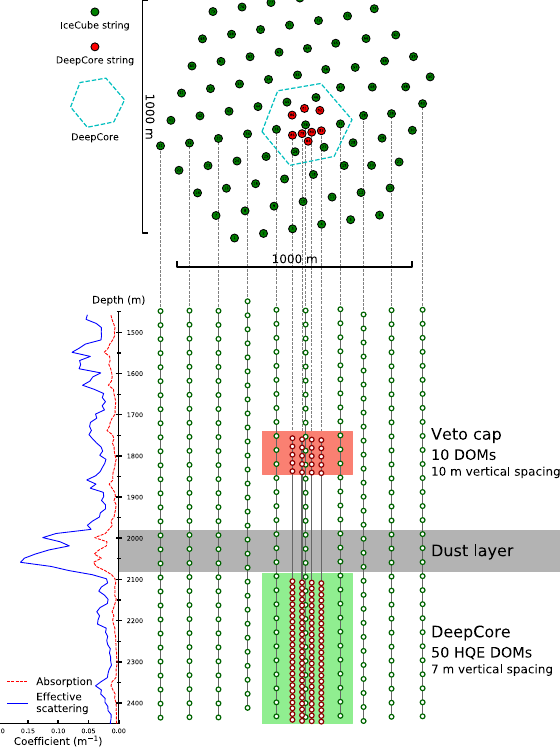
Fig. 1 Schematic view of the IceCube in-ice detector array. The Deep- Core sub-array, located at the bottom center, features denser module spacing and allows for the detection of lower energy events compared to the rest of IceCube. Also shown are the depth-dependent effective scattering and absorption coefficients [17]. The zone labeled as “Dust layer” is of inferior optical quality with increased scattering and absorp- tion. The DeepCore array is located below this in the clearest part of the